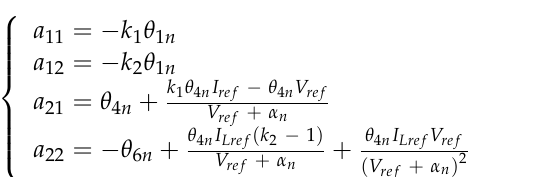
Table 1. Nominal parameters of the buck/boost DC-DC converter.